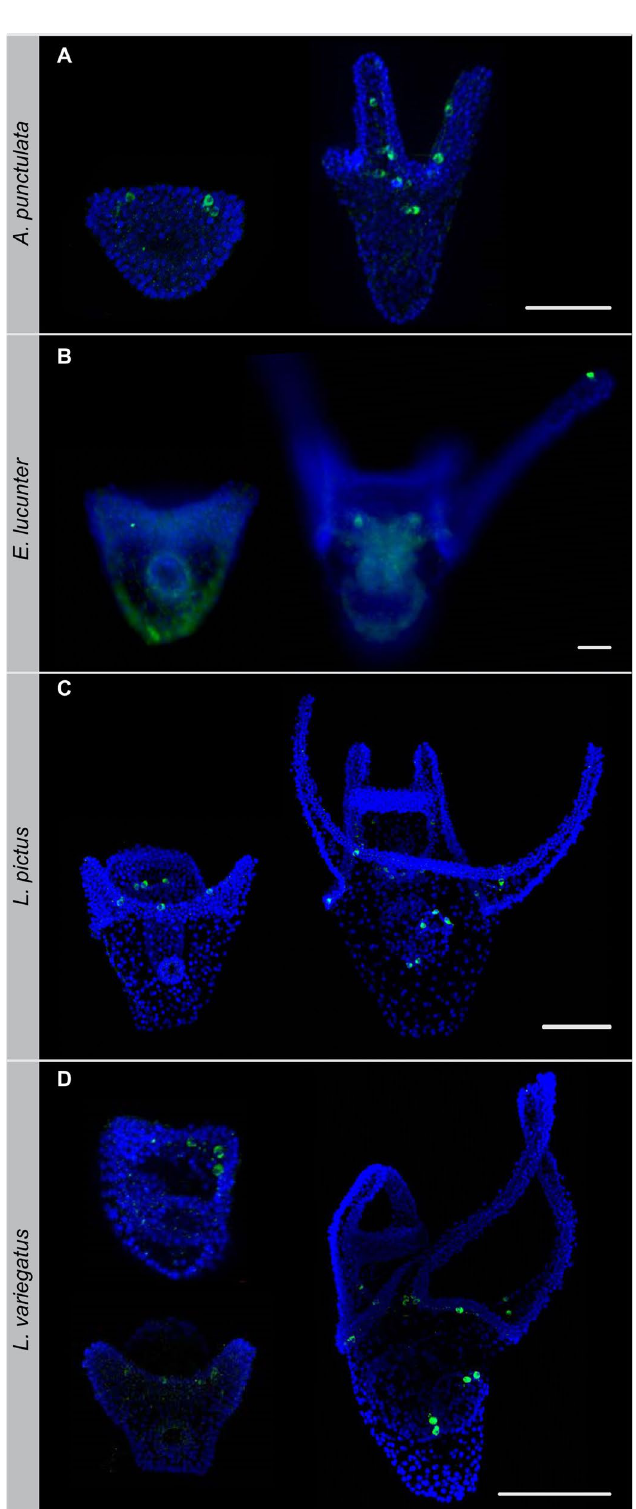
Figure 5. Dopamine neurons develop in the lateral ganglia occurs in most regular urchins. Immunodetection of the dopamine biosynthesis enzyme tyrosine hydroxylase (green) at prism or early pluteus stage (left) and after feeding starts (right) for the regular urchins, A. punctulata ( A ), E. lucunter ( B ), L. pictus ( C ), and the L. variegatus subsp. ( D ). The prism stage is shown for L. variegatus carolinus (top) and L. variegatus variegatus (bottom). DAPI counterstain, Blue. Scale bar, 100 µm all